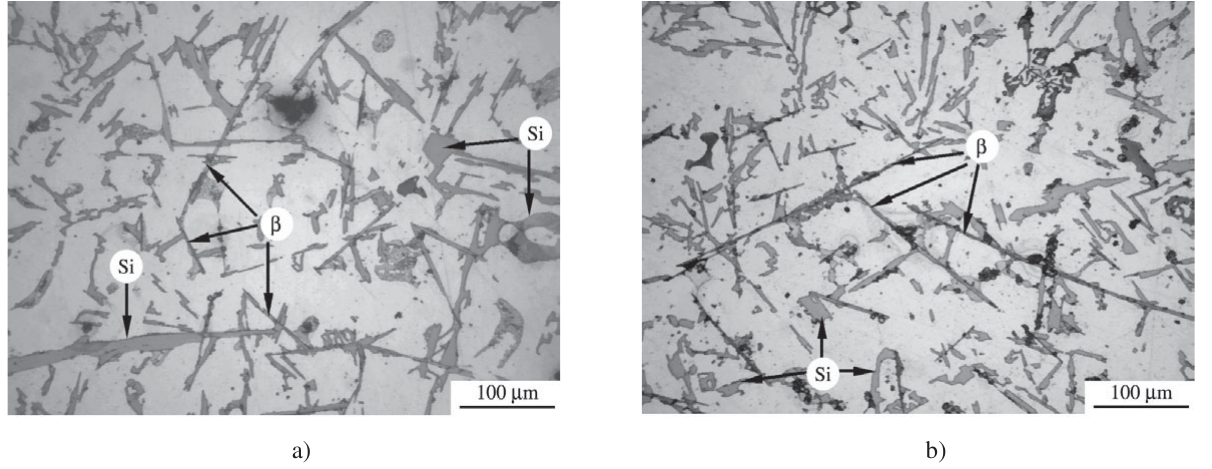
Figure 7. Micrograph of the alloys studied, showing the β phase present. a) alloy 1; b) alloy